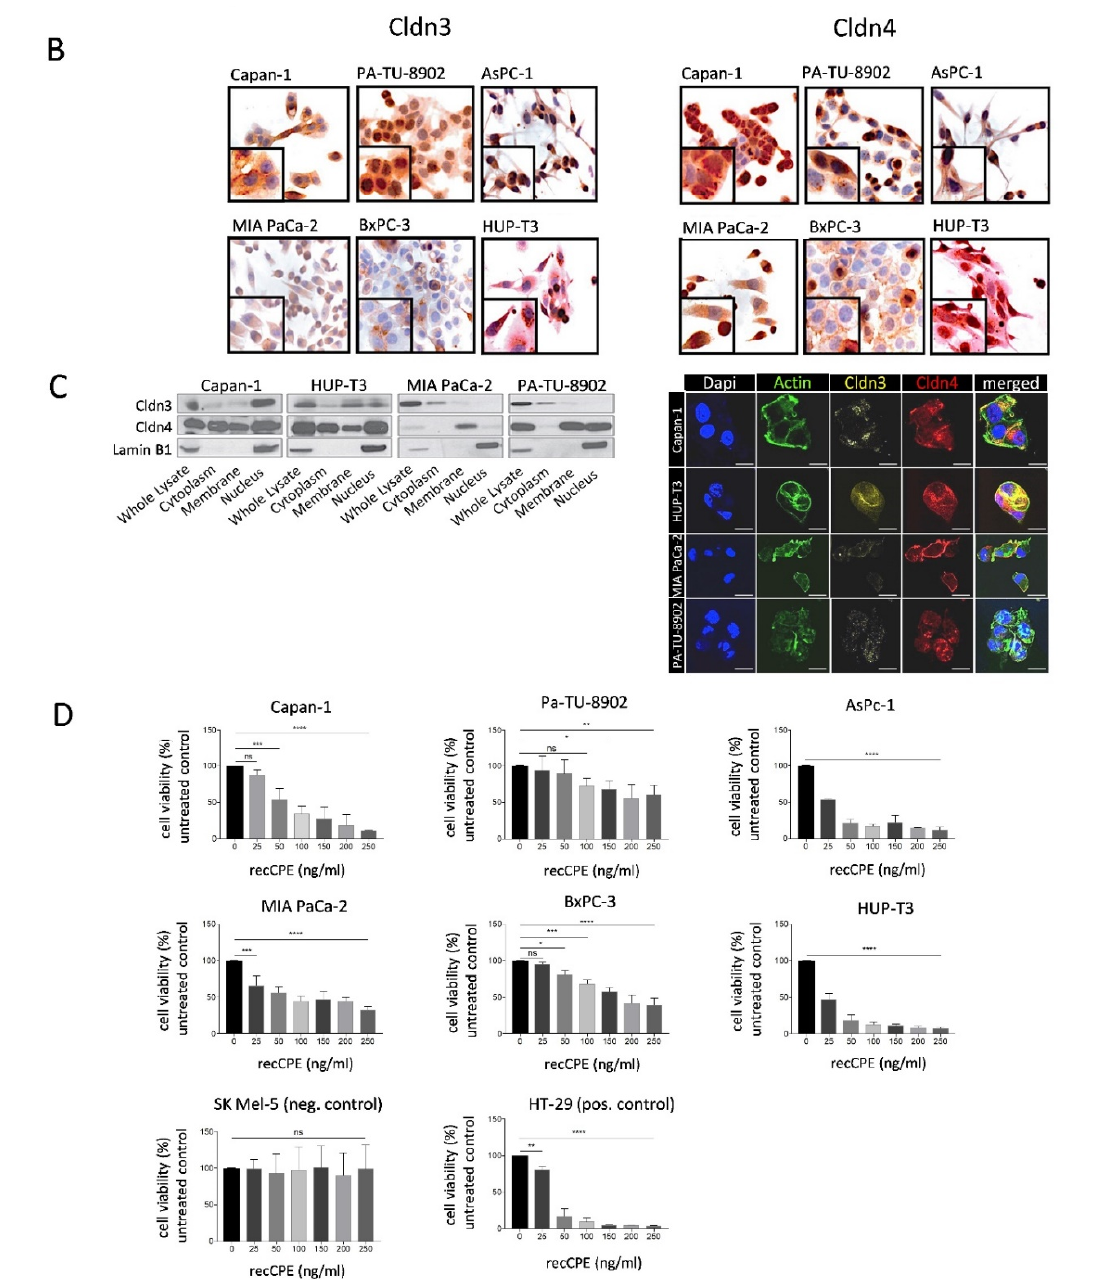
Figure 1. Claudin-3 (Cldn3) and claudin-4 (Cldn4) expression and distribution analysis and sensitivity toward recombinant CPE (recCPE) in human PC cell line panel. ( A ) Quantitative real time PCR (qRT-PCR, graph upper panel) and Western blot analyses (two lower panels for claudin and β -actin, Figure S5) for Cldn3 (left) and Cldn4 (right). The human colorectal cancer cell line HT-29 served as positive control and the human melanoma cell line SK-MEL-5 as negative control with no Cldn3/4 expression. Data are represented as mean values ± S.D. ( n = 3). ( B ) Representative immunohistochemistry of Cldn3 (left) and Cldn4 (right) in respective pancreatic cancer cell lines, demonstrating different distributions of Cldn3/4 (brown). ( C ) Western blot analysis of cell fractions from four PC cell lines using Cldn3/4, and Lamin B1, showing whole cell lysates, cytoplasmic, membrane and nuclear localization (Lamin B1 marker nuclear fraction, Figure S5). Representative immunofluorescence images (right panel) of respective cell lines, confirming diverse Cldn3 (yellow) and Cldn4 (red) expression in different cell compartments (scale bar = 25 µ m). DAPI and actin staining was used for nuclei and cytoplasm, respectively. ( D ) Sensitivity toward recCPE at 72 h post treatment using MTT assay and compared to untreated/solvent treated controls with strong cytotoxic effects in all PC cell lines and positive control line HT-29. SK-MEL-5 negative control cells remained unaffected. MTT data are represented as mean values ± S.D. ( n = 6), expressed as mean percentage of untreated control. (ns: not significant; * p < 0.05; ** p < 0.01; *** p < 0.001; **** p <